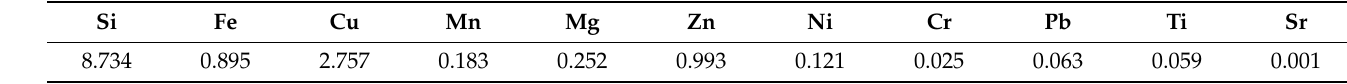
Table 1. Chemical composition provided by supplier of A332 alloy (wt.%).